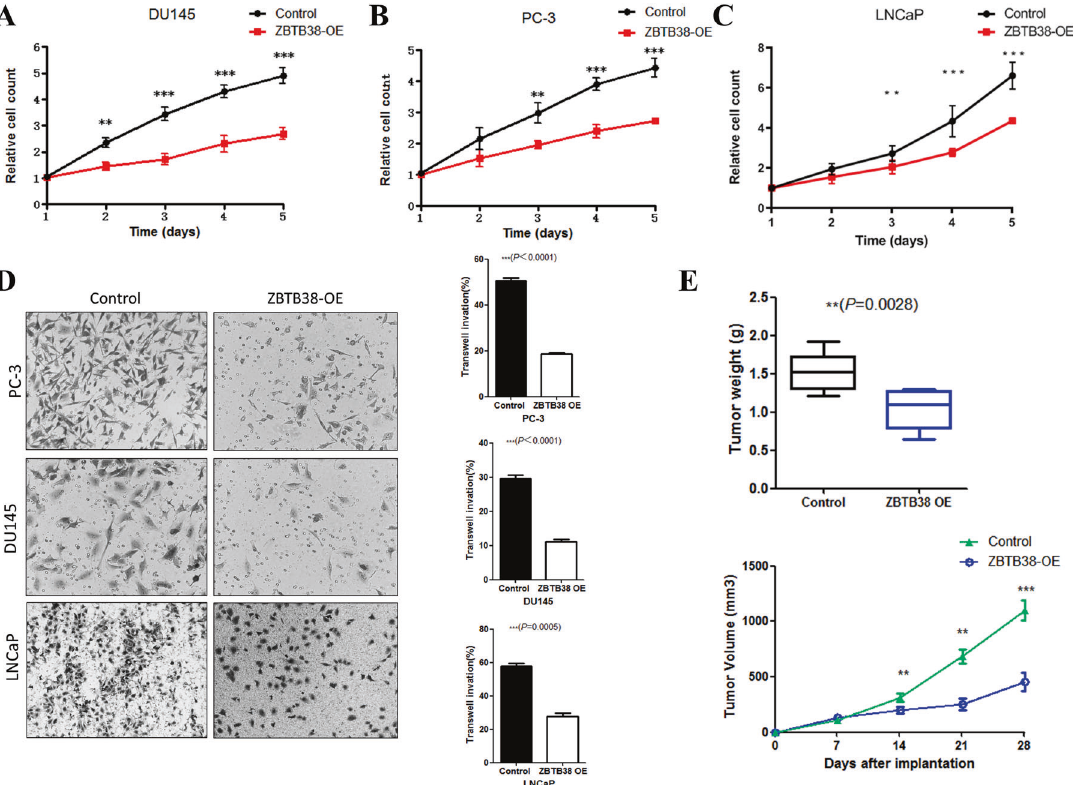
Fig. 2 ZBTB38 suppresses prostate cancer cell proliferation and migration. A Cell proliferation was measured at the indicated time points in DU145 cells (** P < 0.01, *** P < 0.001). B Cell proliferation was measured at the indicated time points in PC-3 cells (** P < 0.01, *** P < 0.001). C Cell proliferation was measured at the indicated time points in LNCaP cells (** P < 0.01, *** P < 0.001). D Transwell assay analyses of the indicated cell lines. E Xenograft analyses of DU145 derived tumors with control vector or ZBTB38 overexpression (** P < 0.01, *** P <